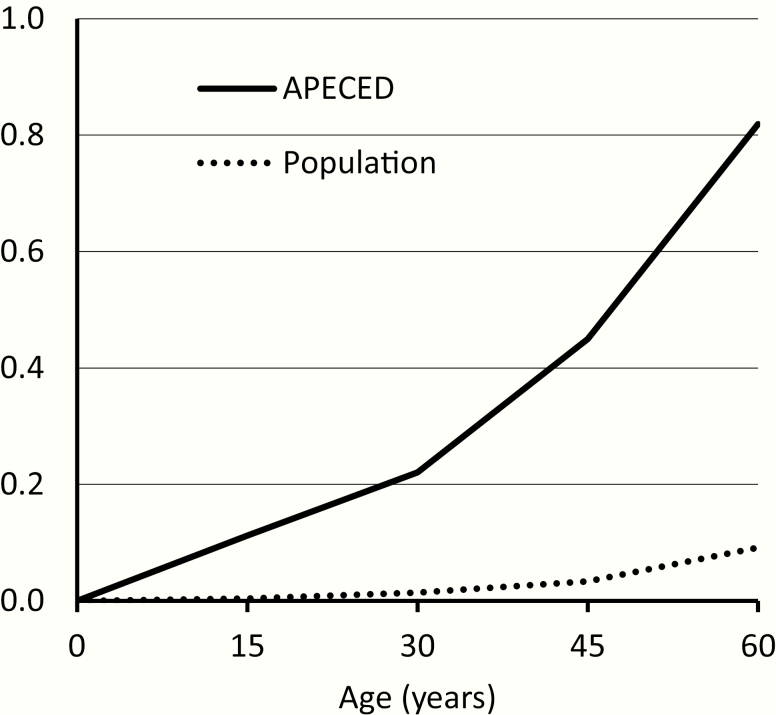
Cumulative all-cause mortality in the cohort of patients with APECED and in the Finnish general population with similar sex and follow-up period distribution. The cumulative values are calculated based on mortality rates for 15-year age groups.